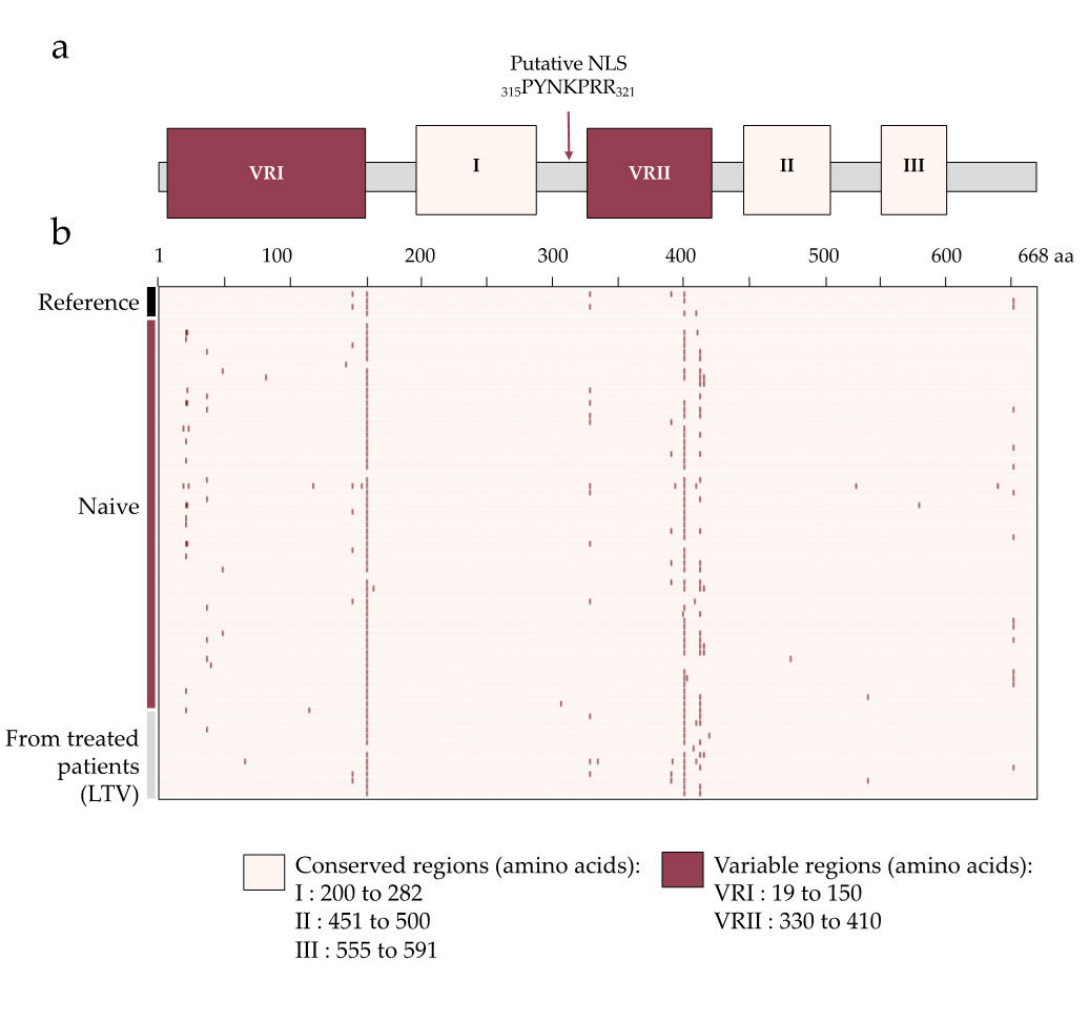
Figure 1. Structure and polymorphism distribution of HCMV pUL52. ( a ) pUL52 is composed of 3 conserved (I–III) and 2 variable regions (VRI and VRII). A putative nuclear localization signal (NLS) of pUL52 is shown by a red arrow at the amino acid position 315 to 321. ( b ) Representation through a binary heatmap of the polymorphism distribution according to the strain and the position of the mutation in pUL52. The 3 groups studied (reference strains ( n = 5), naïve strains ( n = 61) and strains from patients treated with letermovir (LTV) ( n = 14) are represented by black, saddle brown and grey boxes, respectively, in the y axis. Mutations are shown in saddle brown and the absence of a mutation in peach puff. VRI and VRII: variable regions I and II. aa: amino